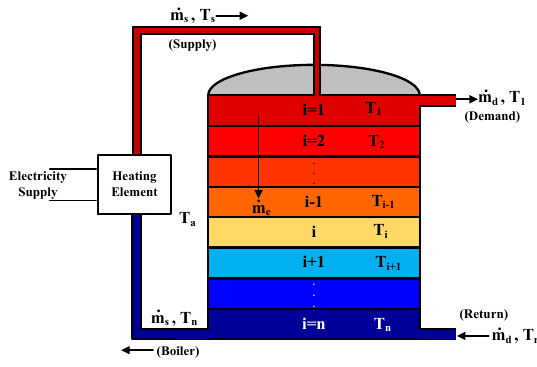
Figure 9. Stratification in hot water storage tank (b) energy flow in stratified